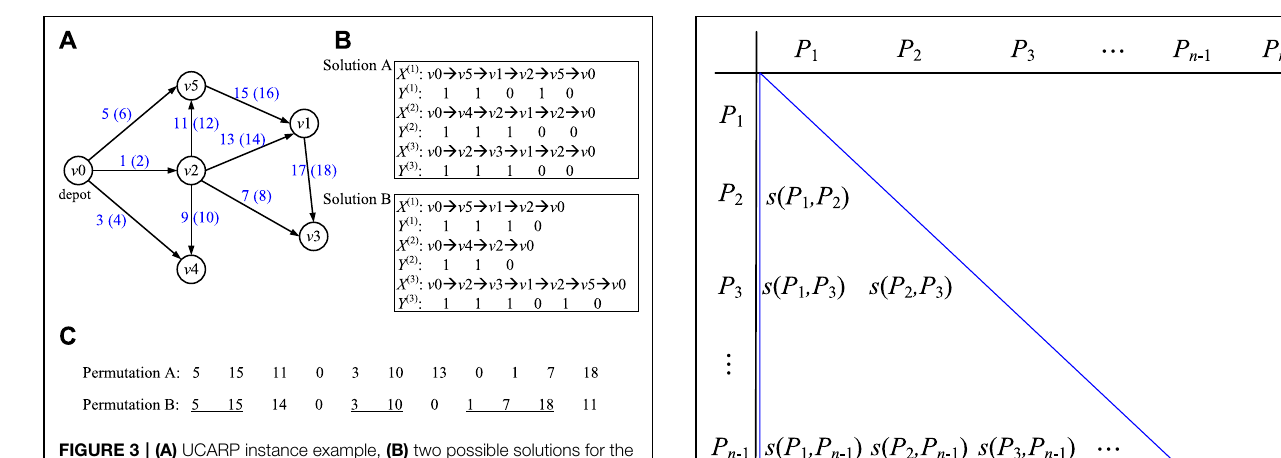
two permutations in the corresponding column and row, and elements in the lower triangular are needed, as shown in Figure 4